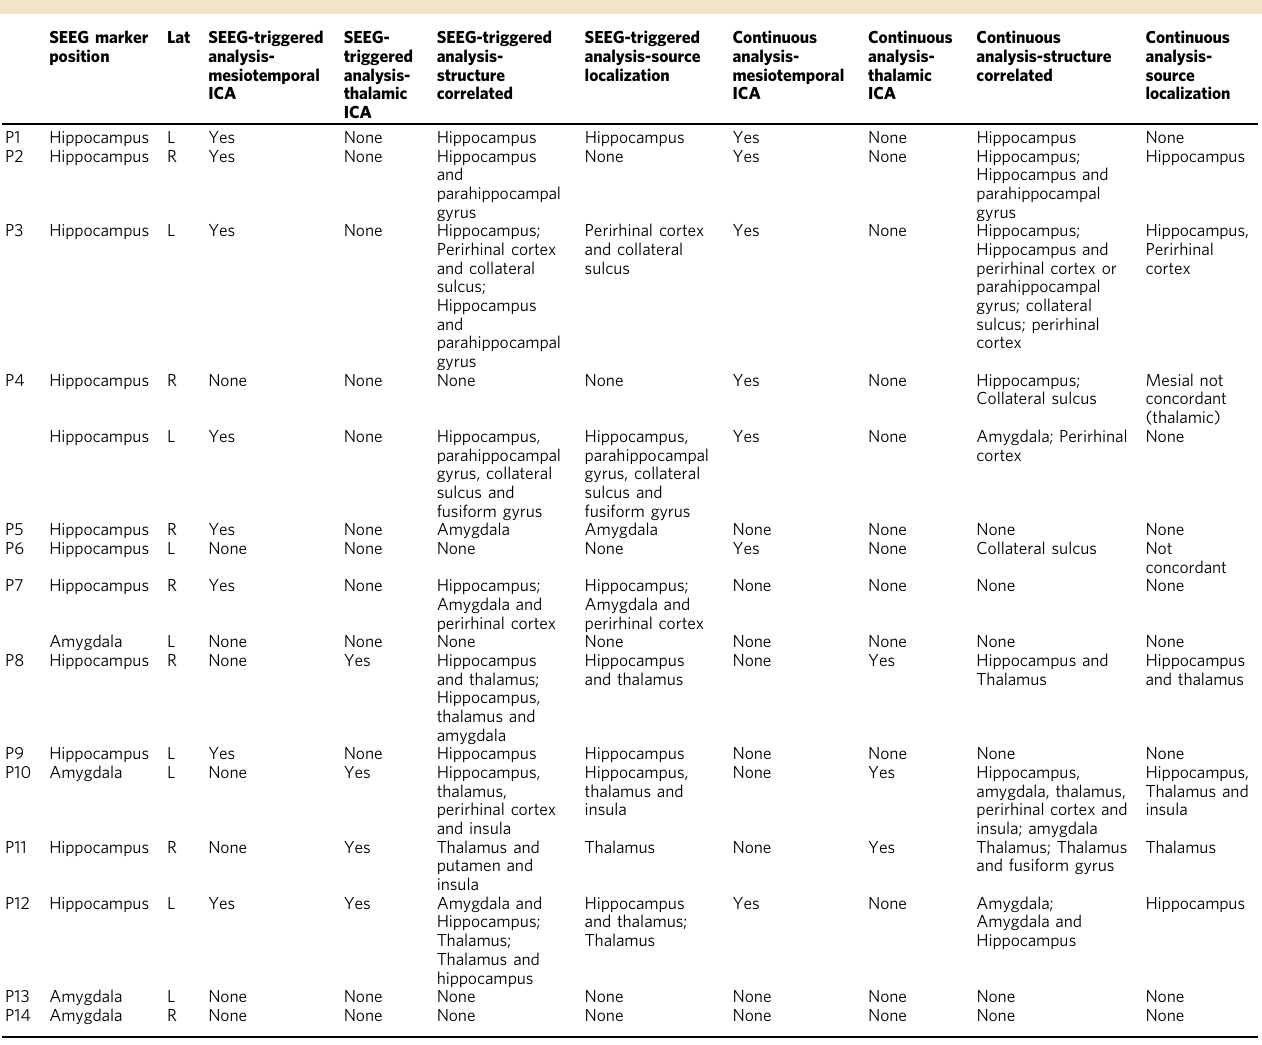
Table 1 Mesial ICA characteristics.